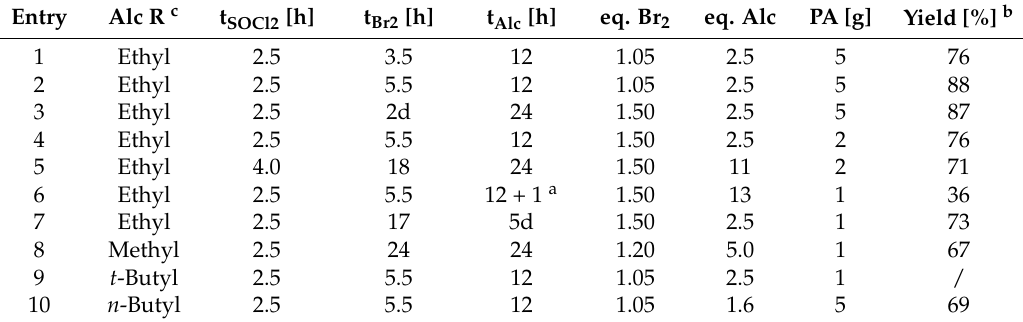
Table 1. Reaction conditions for the preparation of the α -brominated propionic ester [51].